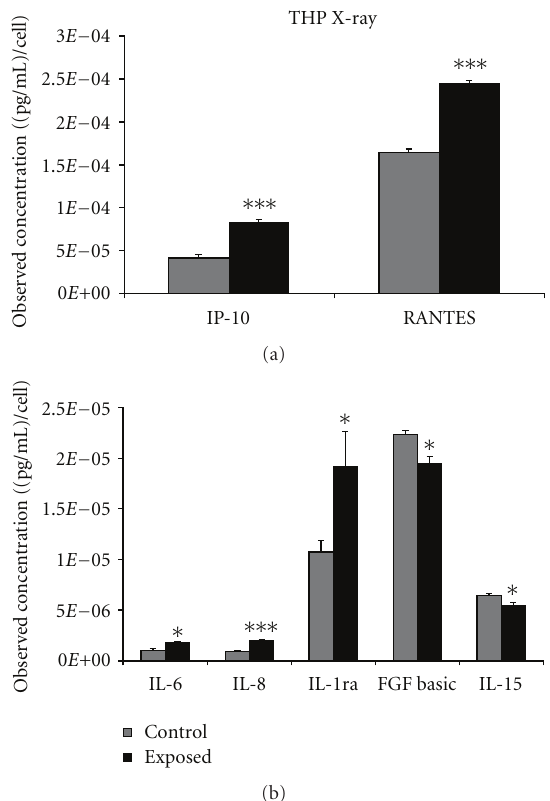
Figure 4: THP-1 cells were seeded into Mylar dishes and exposed to X-radiation at 0 and 1.5Gy. A Bio-plex cytokine assay was performed quantitating 27 di ff erent cytokines, and the results showing statistical significance between control and exposed groups are presented. ∗ represents P < 0 . 05, ∗∗ represents P < 0 . 01, and ∗∗∗ represents P < 0 . 001, n = 5 biological replicates performed in duplicate. Bars are plotted as cell count corrected means ±